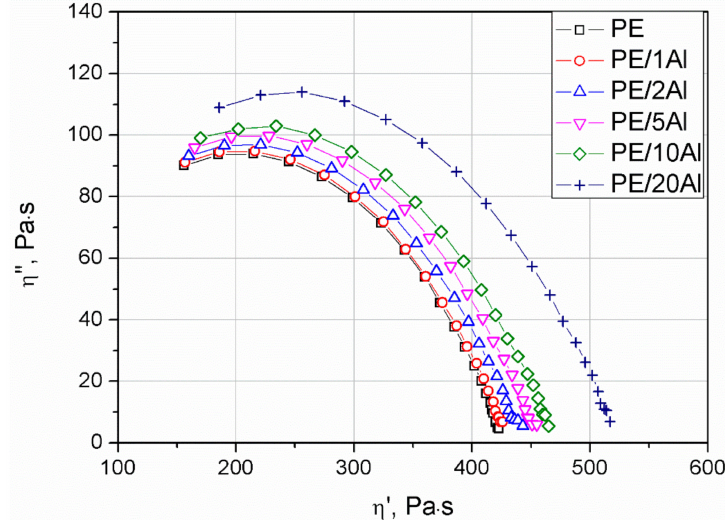
Figure 10. Cole–Cole plots of PE and PE / Al